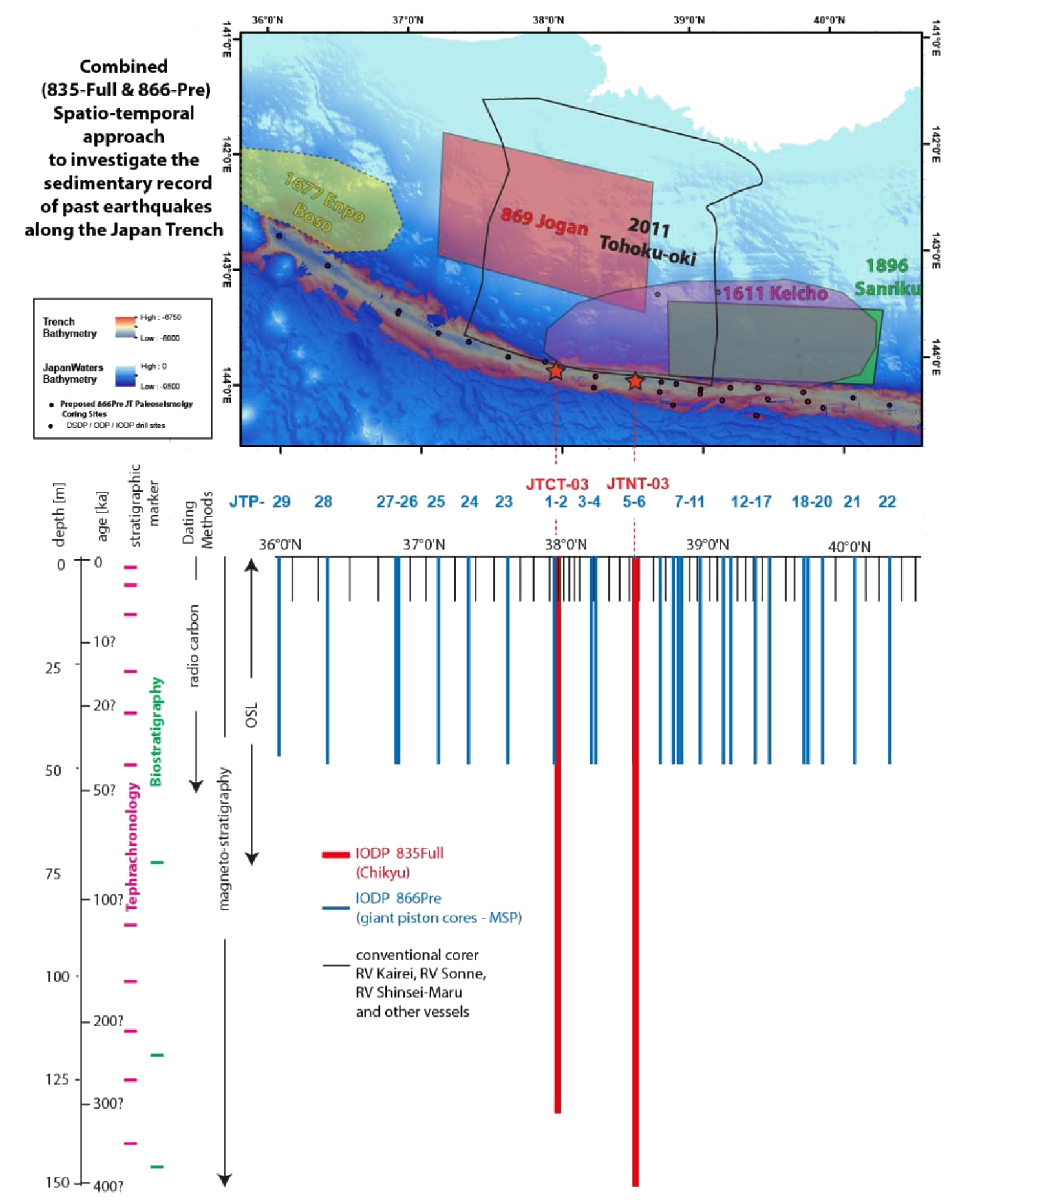
Figure 3. Graphic illustration of the integrated spatiotemporal research approach to investigate the sedimentary record of past earthquakes along the Japan Trench. The figure illustrates the schematic age–depth range (not to scale) and methods to establish absolute (upper part) and relative (lower part) recurrence of extreme event deposits along multiple, trench parallel coring transects by IODP mission-specific platform (MSP) giant-piston coring (JTP-Sites, Proposal 866 Pre) and accompanying short coring campaigns from conventional research